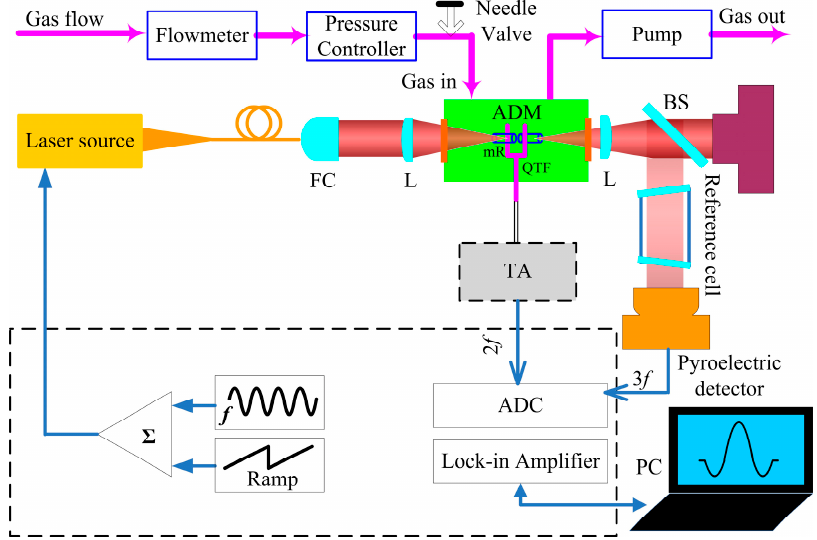
Figure 2. Schematic of the QEPAS sensor. TA: transimpedance amplifier; mR: micro-resonator; ADM: acoustic detection module; L: plano-convex lens; FC: fiber collimator.